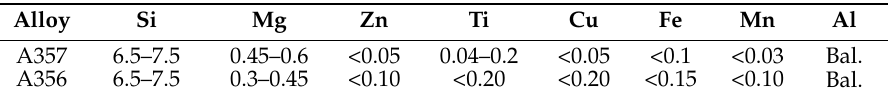
Table 2. Optimized building parameters.